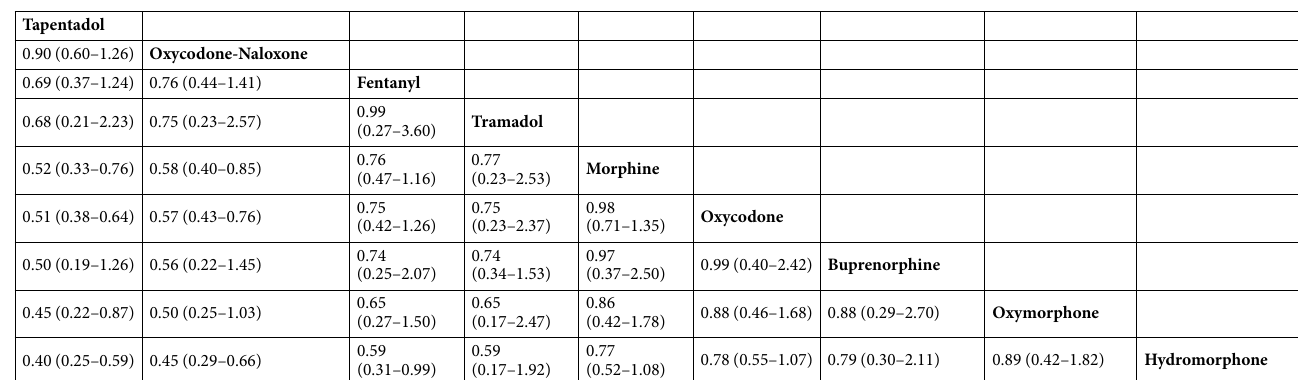
Table 3. League table showing the odds of causing CONSTIPATION by the various opioids. OR < 1 means the treatment in top left is better.